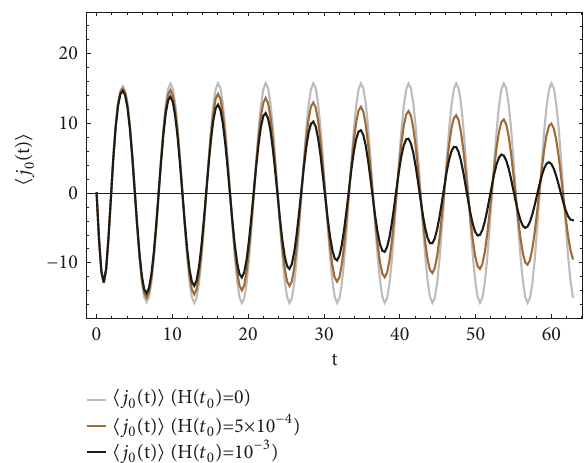
Figure 8: The expansion rate 𝐻(𝑡 0 ) dependence of the time evolution PNA. In horizontal axes, we use the dimensionless time 𝑡 = 𝜔 푟 (𝑥 0 − 𝑡 ) where we choose 𝜔 푟 0 3, 0 (̃𝑚 , ̃𝑚 ,𝐵, 𝜔 , 𝑇) = (2,3, 1.58,0.35,100) for all the lines. The light 1 2 3, 0 gray, brown, and black lines display the cases 𝐻(𝑡 0 ) = 0, 5×10 −4 and 10 −3 , respectively.